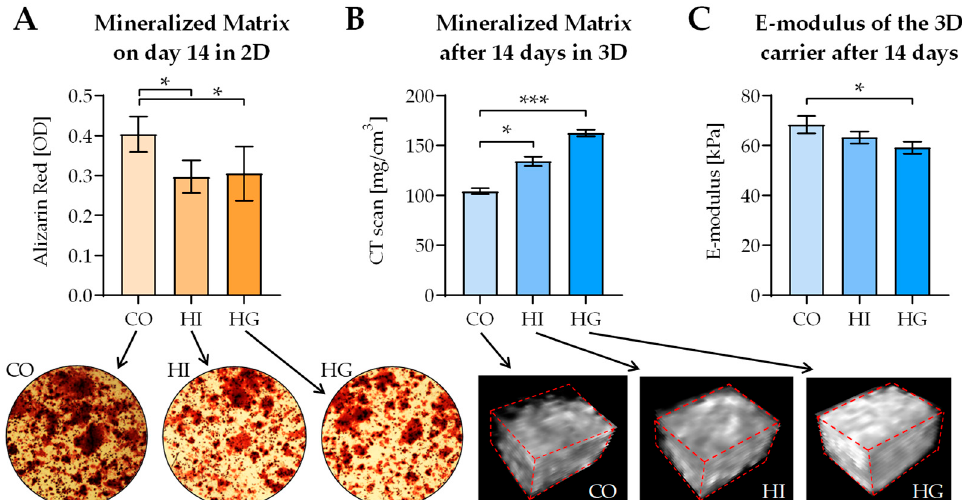
Figure 7. Influence of pre-/diabetic conditions on the formation of mineralized matrix and matrix stiffness in 2D and 3D cocultures of THP-1 cells and SaOS-2 cells. THP-1 cells and SaOS-2 cells (2:1 ratio) were differentiated for 14 days as ( A ) 2D and ( B , C ) 3D coculture, in the presence or absence of high insulin levels (HI = prediabetic conditions) or high glucose levels (HG = diabetic conditions). After 14 days of culture matrix mineralization was quantified by ( A ) Alizarin Red staining in 2D with representative microscopic image and ( B ) quantitative computer tomography (CT) scans in 3D, with a representative 3D reconstruction of the central core of the scaffold. ( C ) In 3D cocultures matrix stiffness (E-modulus) was also determined using a ZwickiLine Z 2.5TN material testing machine. Data, represented as mean ± SEM, were compared by nonparametric Friedmann test, followed by Dunn’s multiple comparison test. * p < 0.05 and *** p < 0.0001 as indicated. N = 3, n =